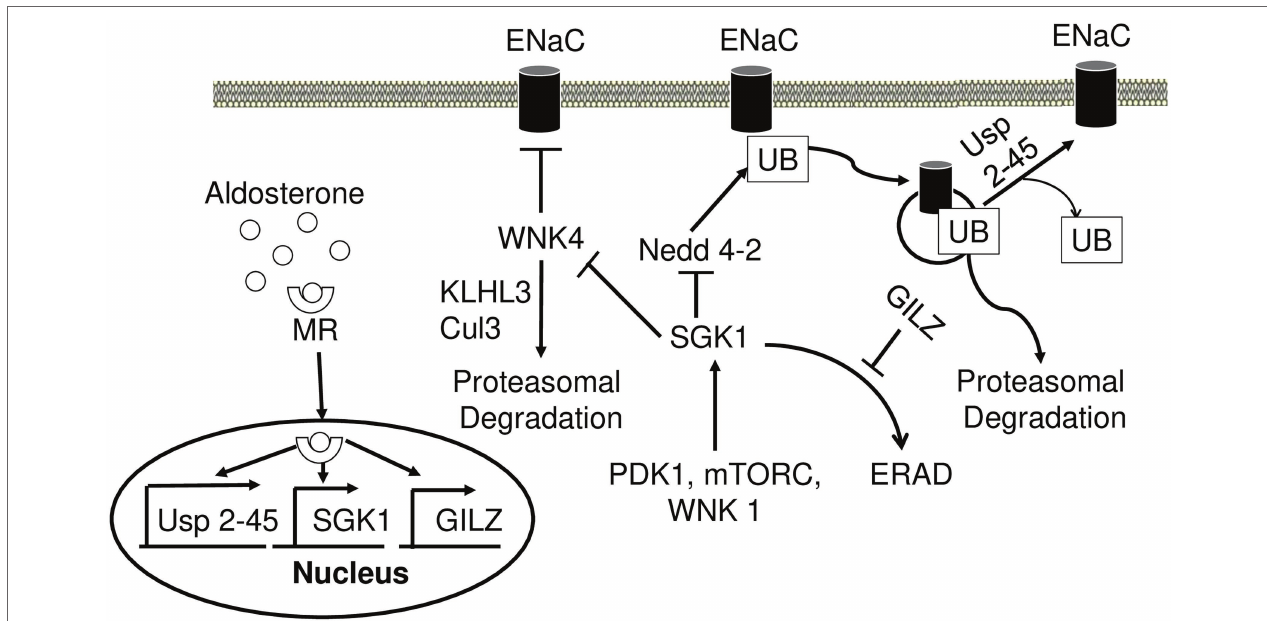
FIGURE 4 | Aldosterone regulates epithelial sodium channel (ENaC) activity and degradation. Aldosterone-bound MR translocates to the nucleus and induces transcription of USP 2-45, SGK1, and GILZ. SGK1 phosphorylates WNK4 and dampens its inhibitory action on ENaC activity. Nedd4-2 ubiquitinates ENaC and signals it for proteasomal degradation. Wnk4 is targeted to proteasomal degradation by KLHL3-Cul3 ubiquitin ligase. SGK1 inhibits this process by phosphorylating Nedd4-2 reducing its affinity to ENaC. USP2-45 removes UB from ENaC preventing its degradation. SGK1 requires phosphorylation events in order to achieve full activity, which is accomplished by PDK1, Wnk1, and mTORC. In the absence of aldosterone, SGK1 is subject to ERAD. However, in the presence of aldosterone GILZ inhibits this process increasing the stability of SGK1. MR, mineralocorticoid receptor; SGK1, serum glucocorticoid-induced kinase 1; GILZ, glucocorticoid- induced leucine zipper 1; Nedd4-2, Neural precursor cell expressed developmentally downregulated gene 4; ENaC, epithelial sodium channel; UB, ubiquitin; PDK1, pyruvate dehydrogenase kinase; ERAD, endoplasmic reticulum-associated